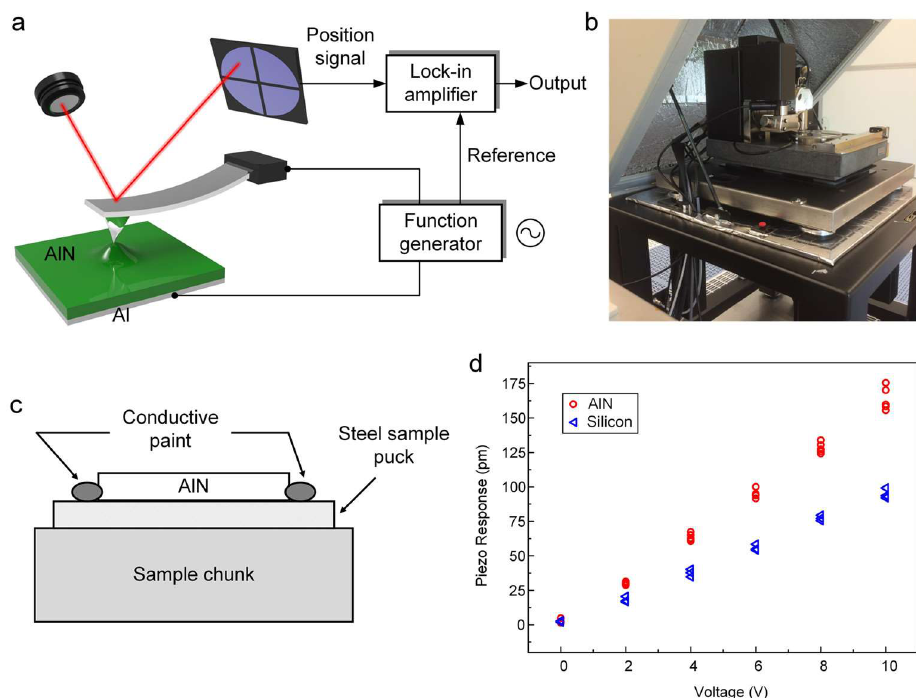
Figure 6. ( a ) Schematic illustration and ( b ) photography of the PFM measurement setup; ( c ) schematic illustration of the sample being prepared on the chunk; ( d ) relationship between piezoresponse amplitude and modulating AC bias voltage amplitude obtained from the PFM measurement.